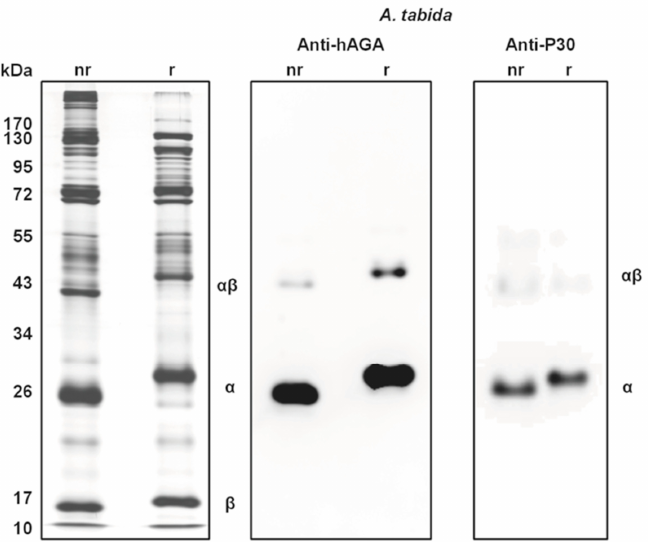
Figure 5. SDS-PAGE separation of A . tabida venom extracts and asparaginase (AGA) immunostaining. Electrophoretic profiles of venom extracts and immunostaining of AGA under non-reducing conditions (nr) and reducing conditions (r). Gels were silver-stained or analyzed by western blot using the anti-hAGA and anti-P30. The two subunits are indicated α and β , and the heterodimer by αβ . ( A . tabida AGA) antibodies. (Source: from [142] under the terms of Creative Commons Attribution Licence CC-BY 4.0 via PLoS ONE ).